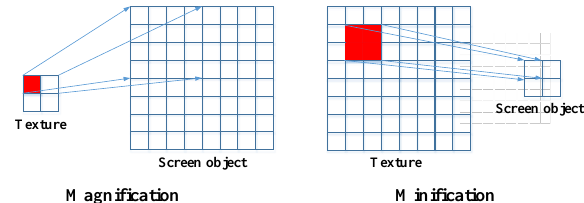
Figure 10. Rendering a segment which is visible in a single